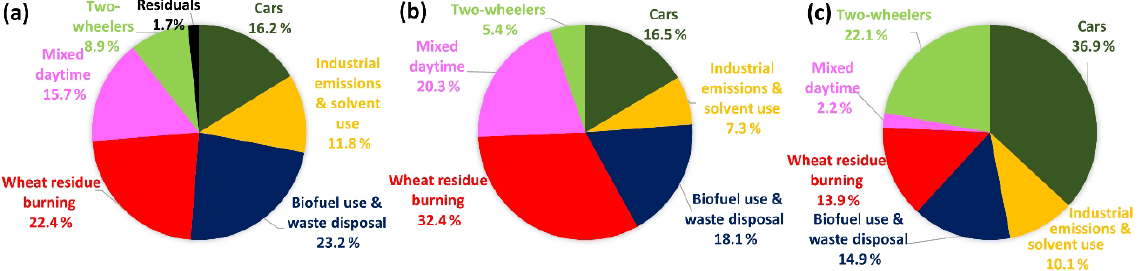
Figure 4. (a) Source contribution to the ambient VOC loading at the receptor site. (b) Ozone formation potential for PMF-derived sources. (c) SOA potential for PMF